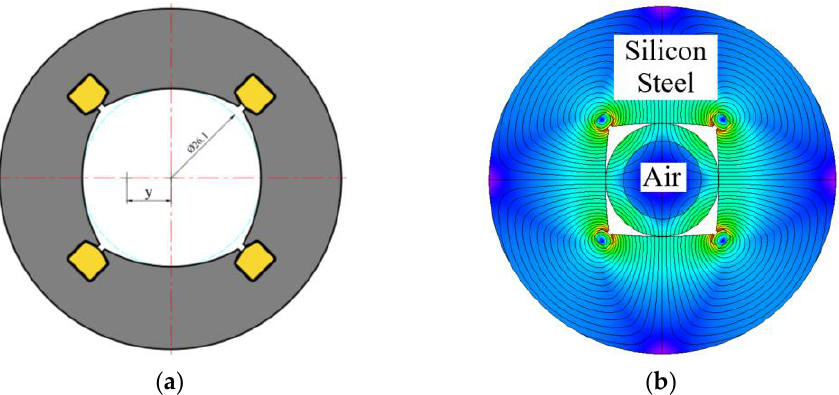
Figure 5. ( a ) Schematic diagram of eccentric magnetizing fixture. ( b ) Magnetization simulation cloud chart.